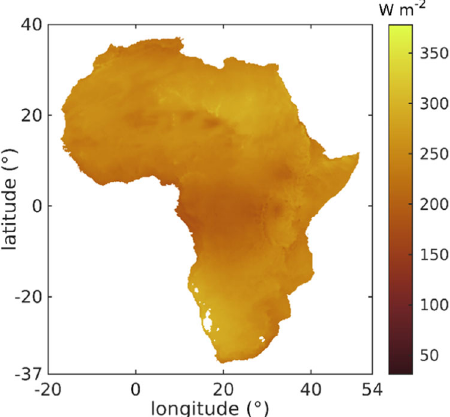
Fig. 3 Irradiance G pv on optimally tilted PV modules. Average over the year for 2020 (yellow